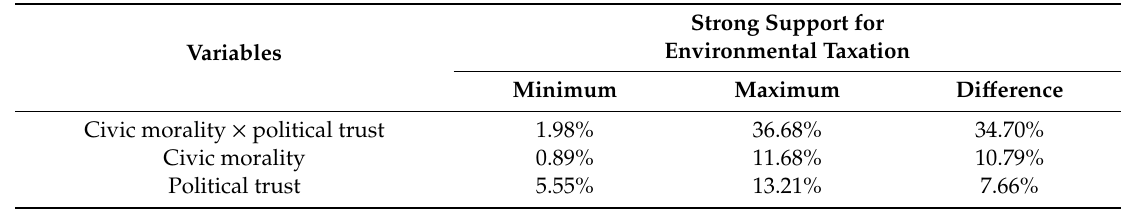
Table 3. Predicted probabilities of strong support for environmental taxation.